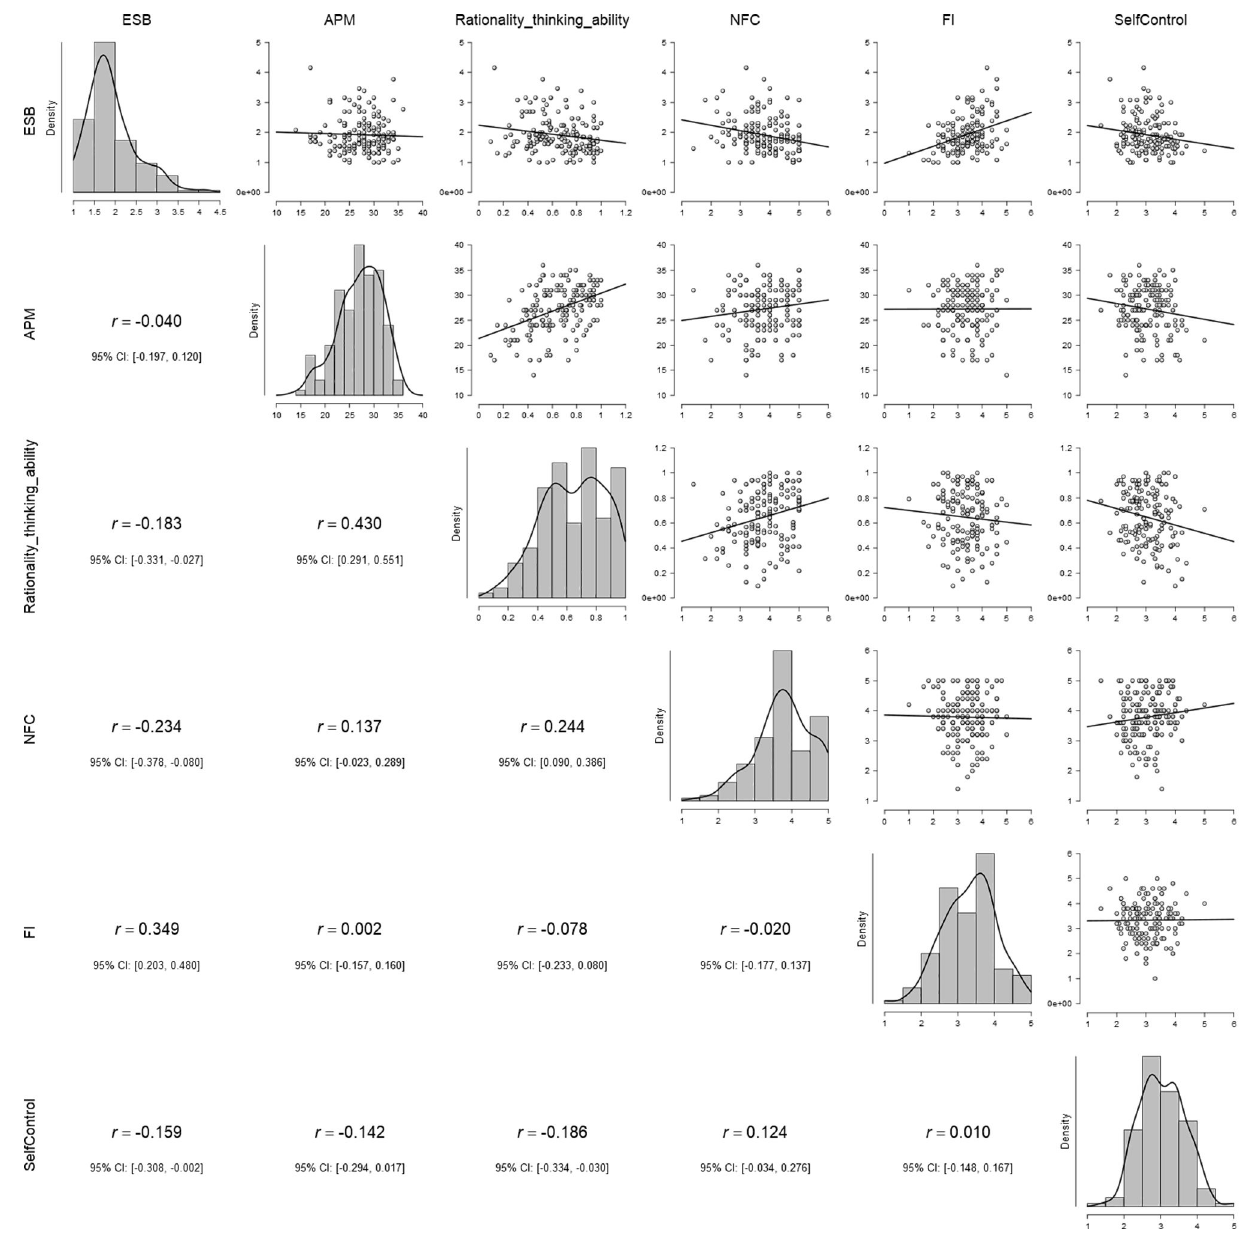
Figure A. The distributions of the variables measured within the study, together with scatter plots and correlation coefficients representing the relationships between them. Note . ESB = Epistemically Suspect Beliefs; APM = Advanced Progressive Matrices; NFC = Need for Cognition; FI = Faith in